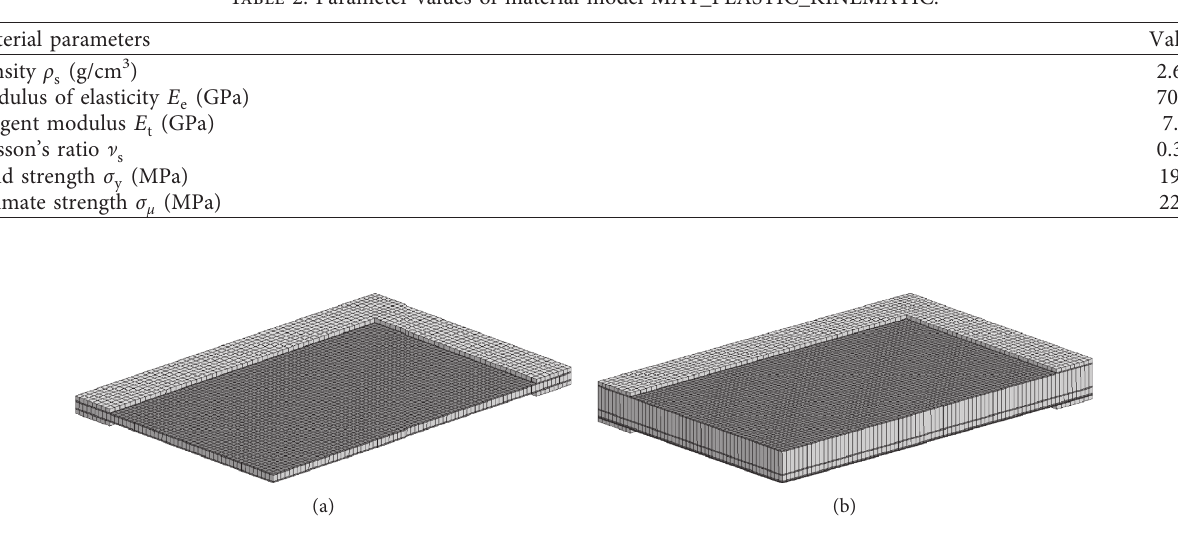
Figure 24: Constitutive curve of enhanced honeycomb structure. Table 2: Parameter values of material model MAT_PLASTIC_KINEMATIC.